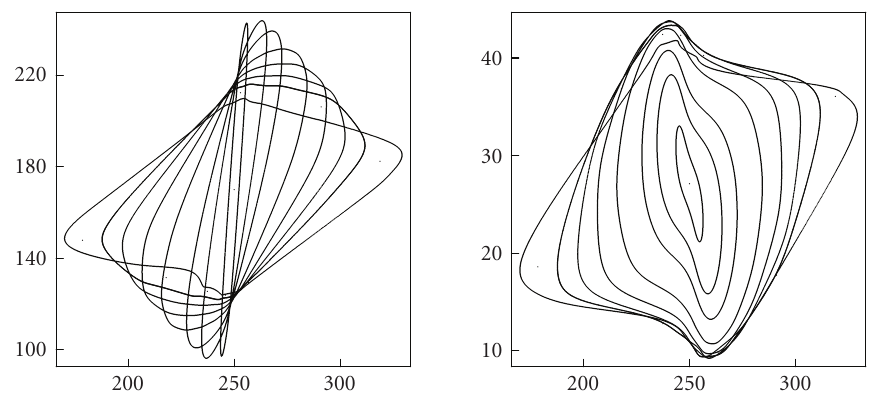
Figure 6.1. Development of cyclical attractors for β = 0 . 2. Projections in the Y - K (left) and Y - M (right) planes.